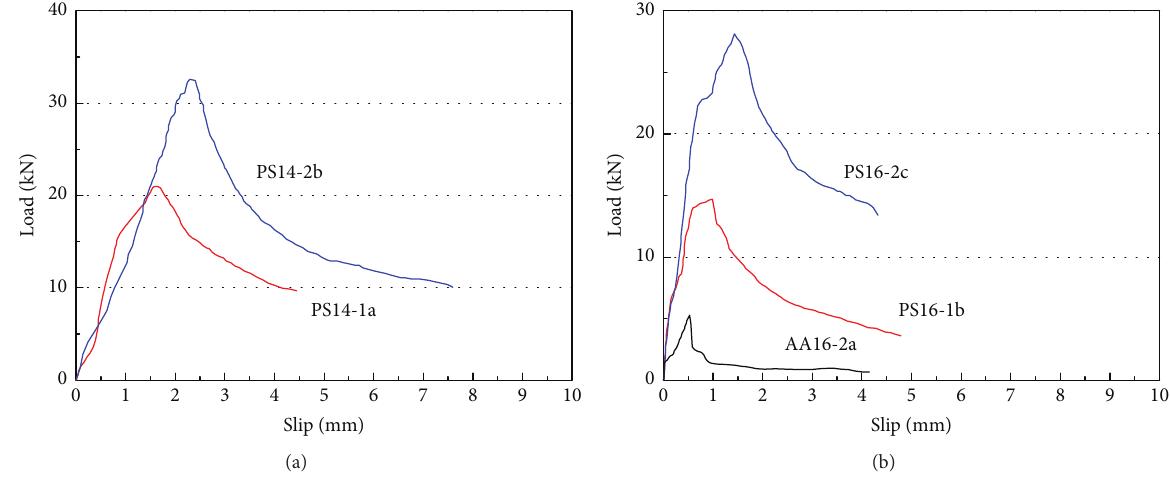
Figure 5: Load versus slip curves of typical specimens: (a) diameter of 14mm and (b) diameter of 16 mm.